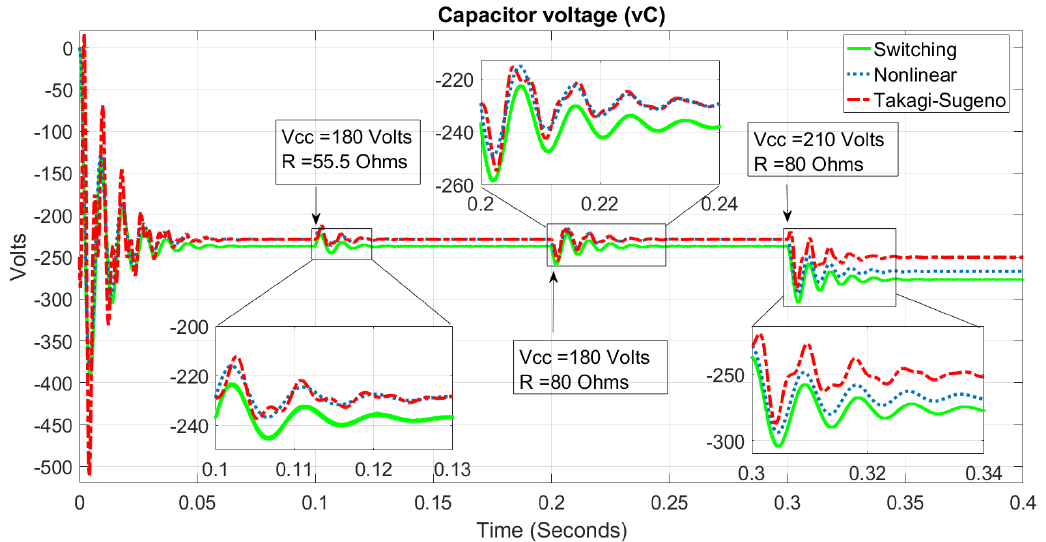
Figure 9. Comparison of the models capacitor voltage dynamics.